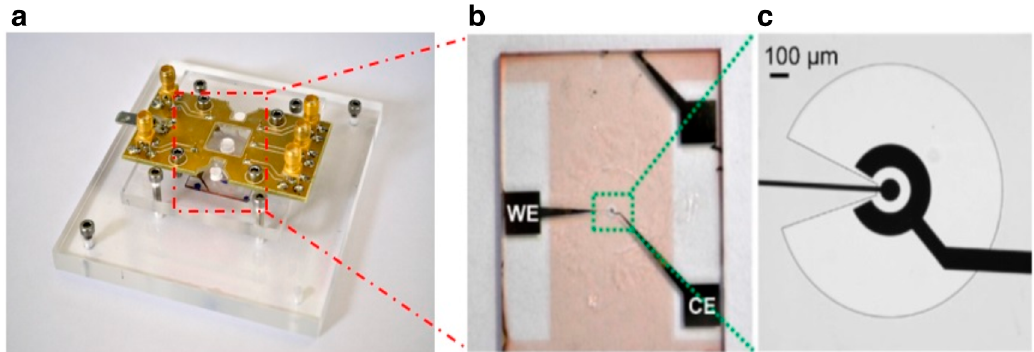
Figure 2. ( a ) Sample holder equipped with an electronic card to bring the signal to the HEKA-bipotentiostat; ( b ) microfabricated working and counter gold electrodes (black) on the patterned insulation layer (SPR 220 1.2) (pink); and ( c ) zoom-in of the central part of the electrodes. The diameter of the WE in contact with the solution is 100 µ m. The patterned resist used to electrically insulate the electrodes is clearly recognizable as the darker-gray outer area of the image.